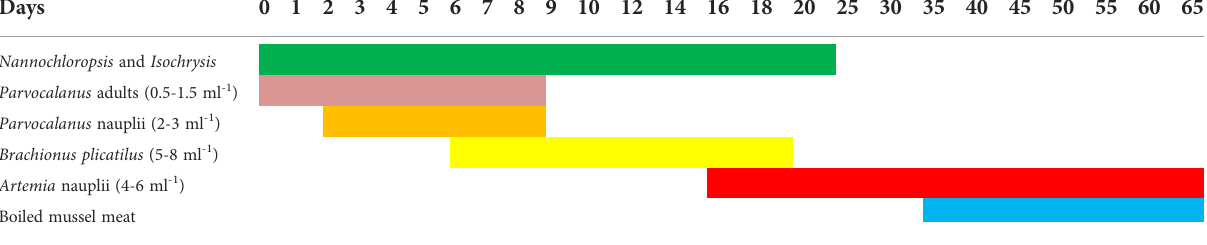
TABLE 6 Feeding schedule of hatchery reared Damsels .